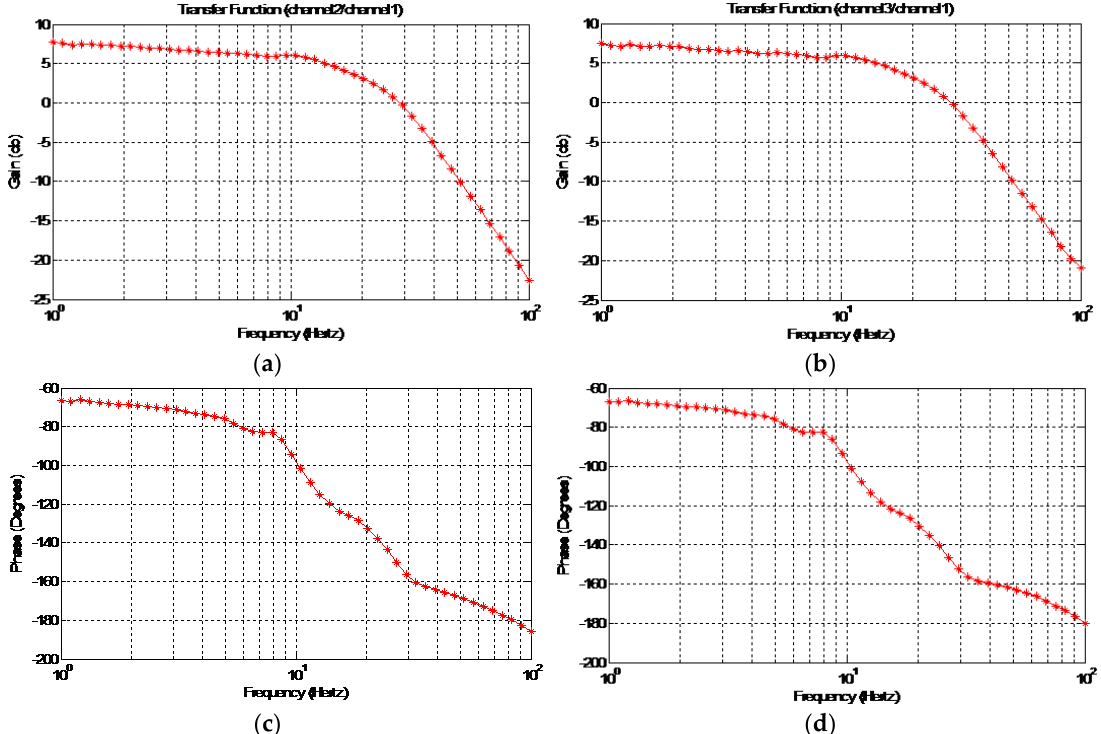
Figure 9. The Bode diagram of VCM open loop sweep frequency. ( a ) Amplitude frequency curves, in which the output signal is the angle signal after Hall sensor calibration; ( b ) amplitude frequency curves, in which the output signal is the incremental encoder angle signal; ( c ) phase frequency curves, in which the output signal is the angle signal after Hall sensor calibration; ( d ) phase frequency curves, in which the output signal is the incremental encoder angle signal.